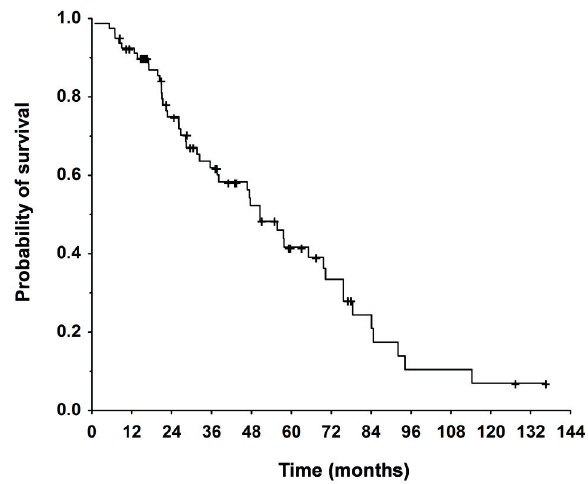
Fig. 1. Overall survival from the date of